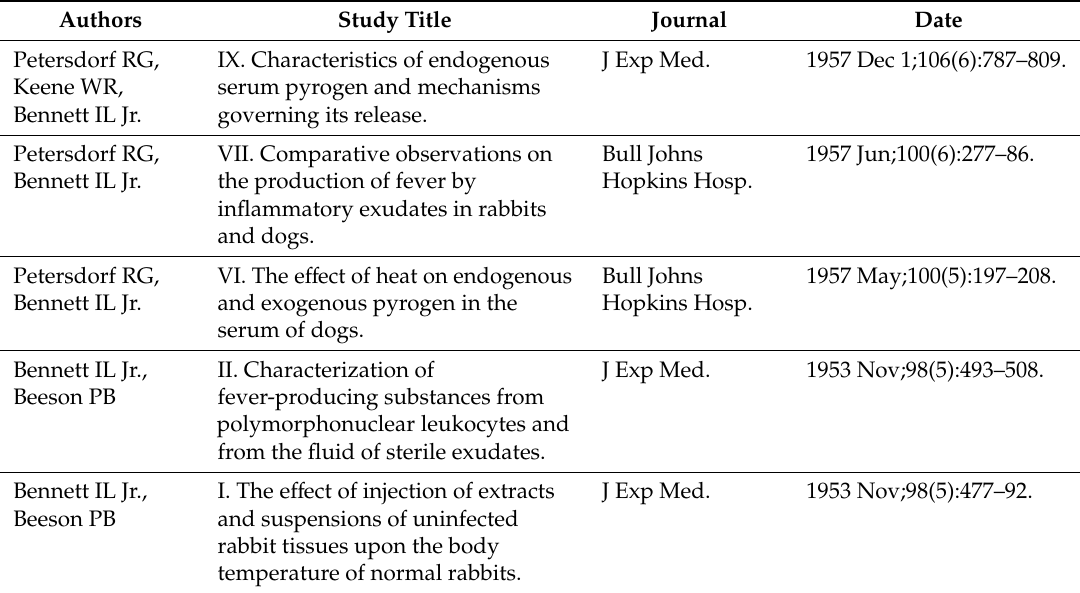
Table 1. Selected studies by JL Bennett in the “Studies on the pathogenesis of fever”